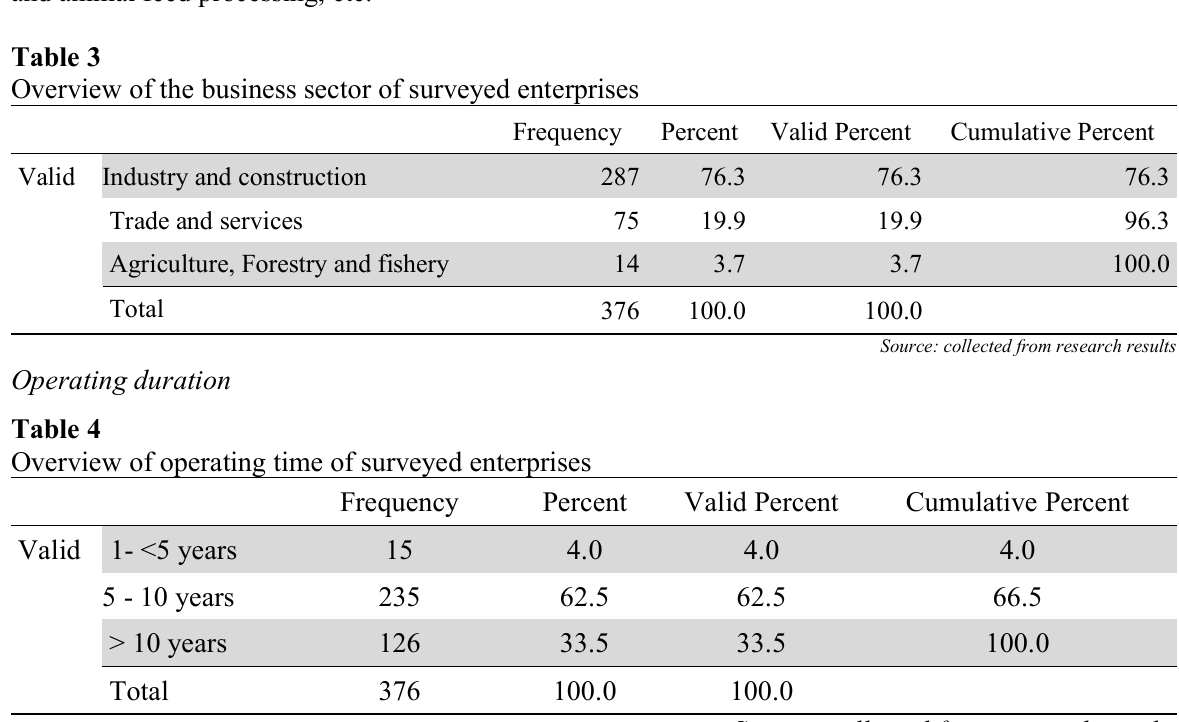
Overview of the business sector of surveyed enterprises Valid